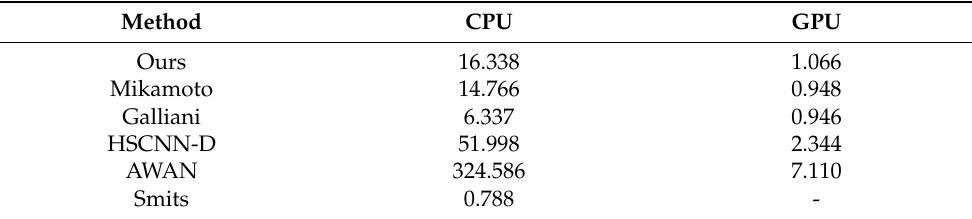
Table 5. Comparison of conversion time from RGB to HS (the unit is seconds). CPU is Intel Core i9-11900, and GPU is NVIDIA GeForce RTX 3090.